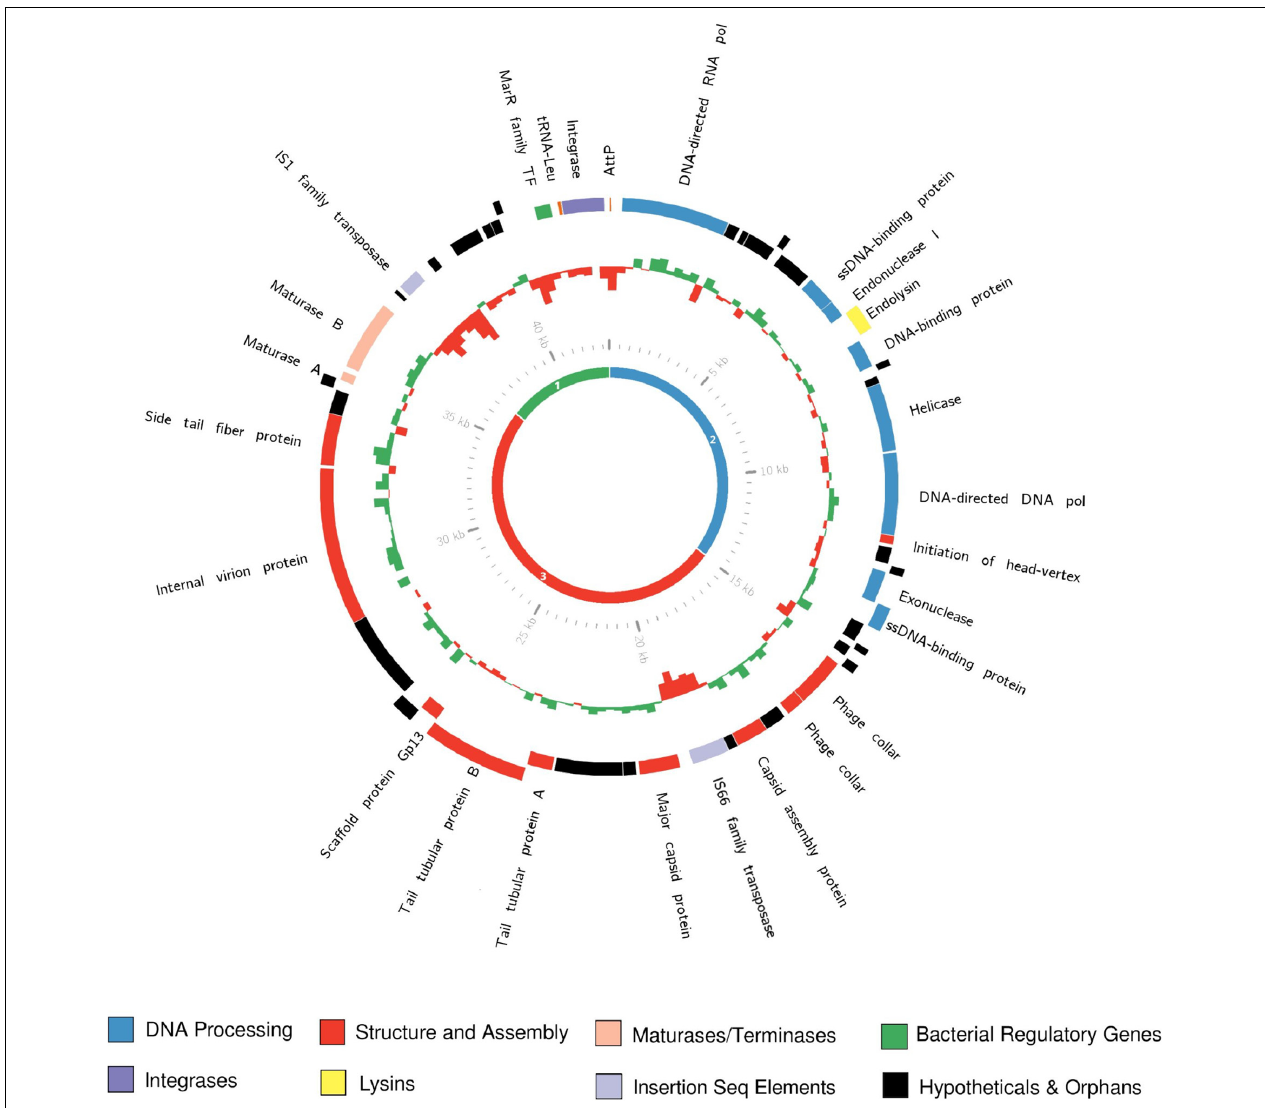
FIGURE 4 | The annotated genome of vTRX32-1. The outer ring shows ORFs predicted by RAST, with colors corresponding to their predicted functions. The inner histogram represents GC%, GC% above the genome average is green and GC% below the average is red. Histogram size indicates the disparity between the GC% at that locus (250 bp bins) and the genome average GC%. The central ring shows the location of the 3 gene classes in the vTRX32-1 genome (green, blue, and red corresponding to early, middle, and late,